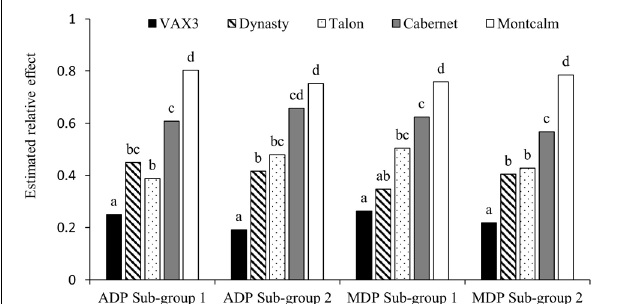
FIGURE 1 | Assay reproducibility of the five control lines when screened for root rot caused by Fusarium solani within sub-group evaluations of Phaseolus vulgaris Andean Diversity Panel (ADP) and Middle American Diversity Panel